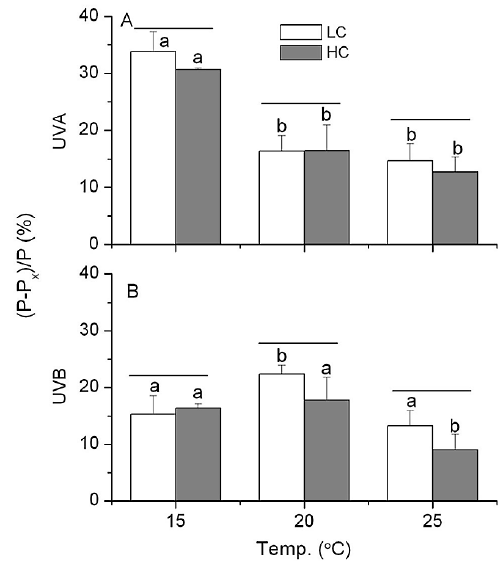
Fig. 7. Inhibition of photosynthetic carbon fixation of P. tricornutum grown at ambient (LC, white bars) and elevated CO 2 (HC, black bars) concentrations due to UV-A (A) or UV-B (B) exposed to three radiation treatments for 60min at 15, 20 and 25 ◦ C. The bars rep- resent the means ( n = 3), and the vertical lines on top are the stan- dard deviation. Lines above the histogram bars indicate significant difference between LC and HC, and different letters indicate signif- icant differences among the temperature treatments within the HC- or LC-grown